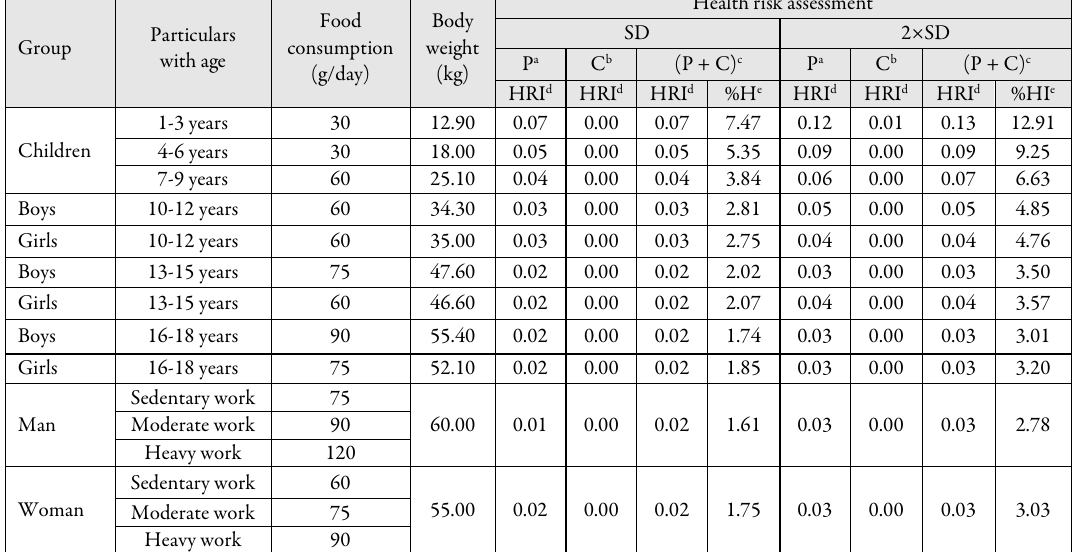
fruit for different groups of Indian